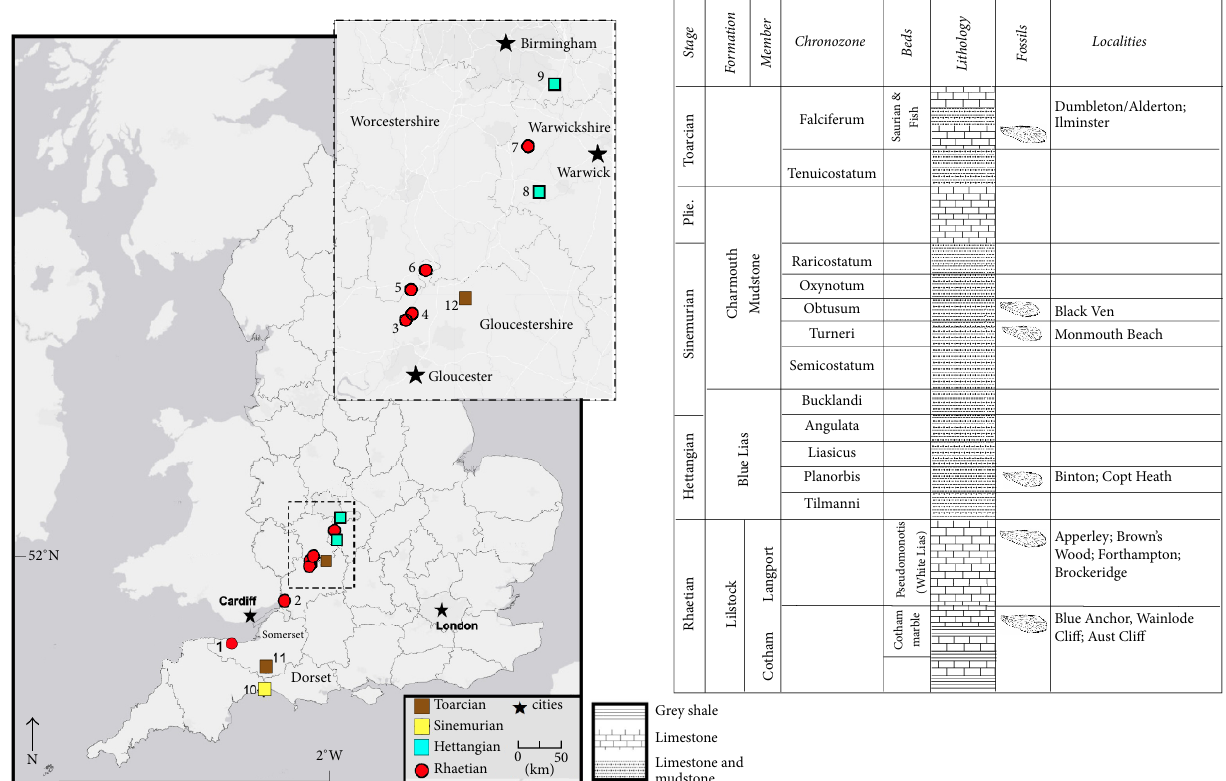
Figure 1: Locality map. (1) Blue Anchor,(2) Aust Cliff, (3) Wainlode Cliff, (4) Apperley,(5) Forthampton, (6) Brockeridge, (7) Brown’s Wood, (8) Binton, (9) Copt Heath, (10) Monmouth Beach, (11) Ilminster, and (12) Alderton Hill/Dumbleton